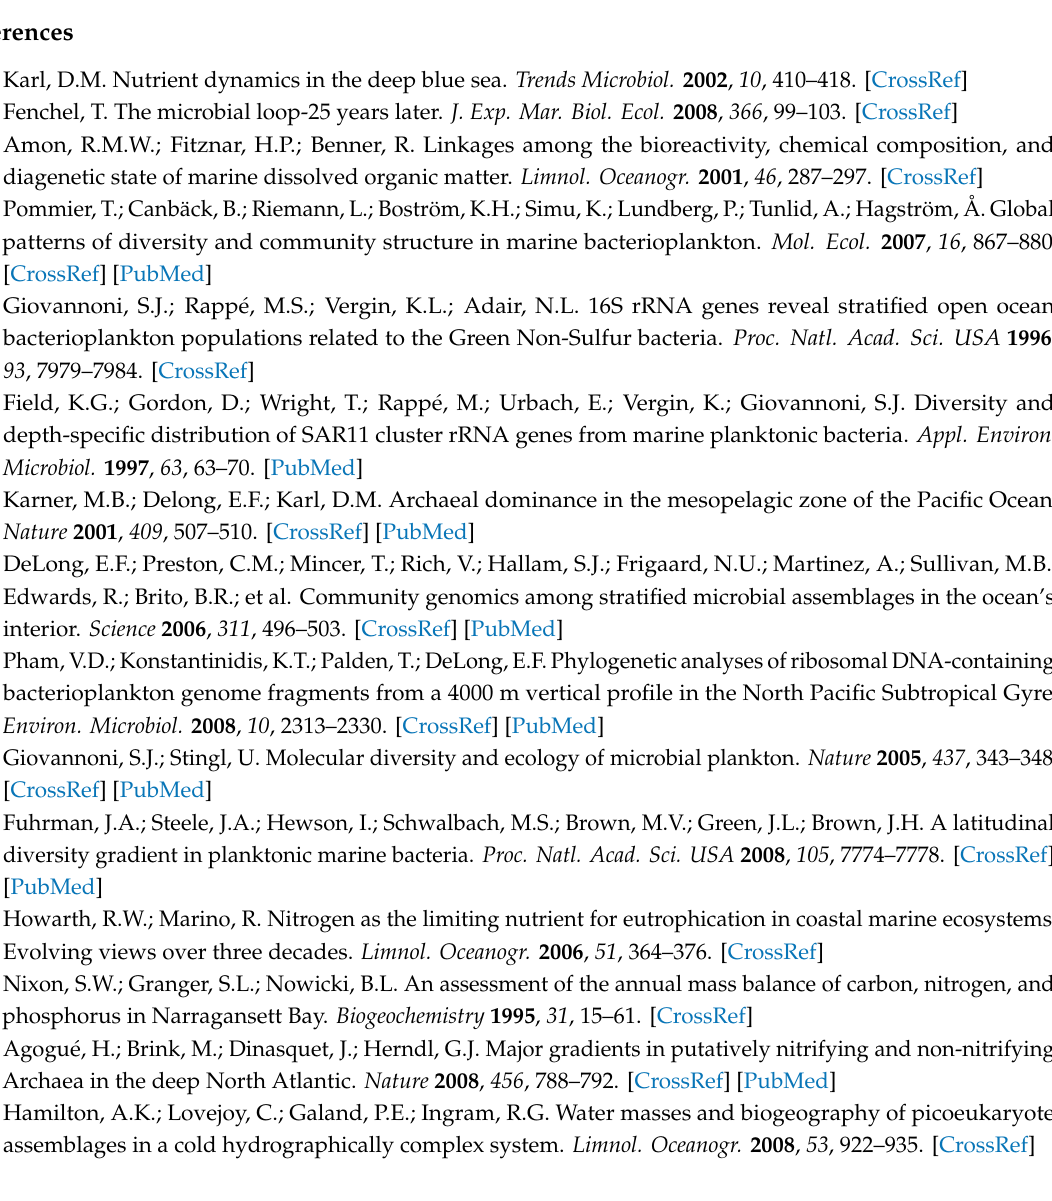
Table S1. Information for SAR11 reference sequences, Table S2. PCA correlation coordinates of all environmental parameters for analyses done at di ff erent taxonomic levels, Table S3. Inorganic nutrient concentrations for samples in our study, Figure S1. Principal component analysis (PCA) based on the physical and chemical properties of 10 samples, Figure S2. Relationship between sequencing e ff ort and diversity